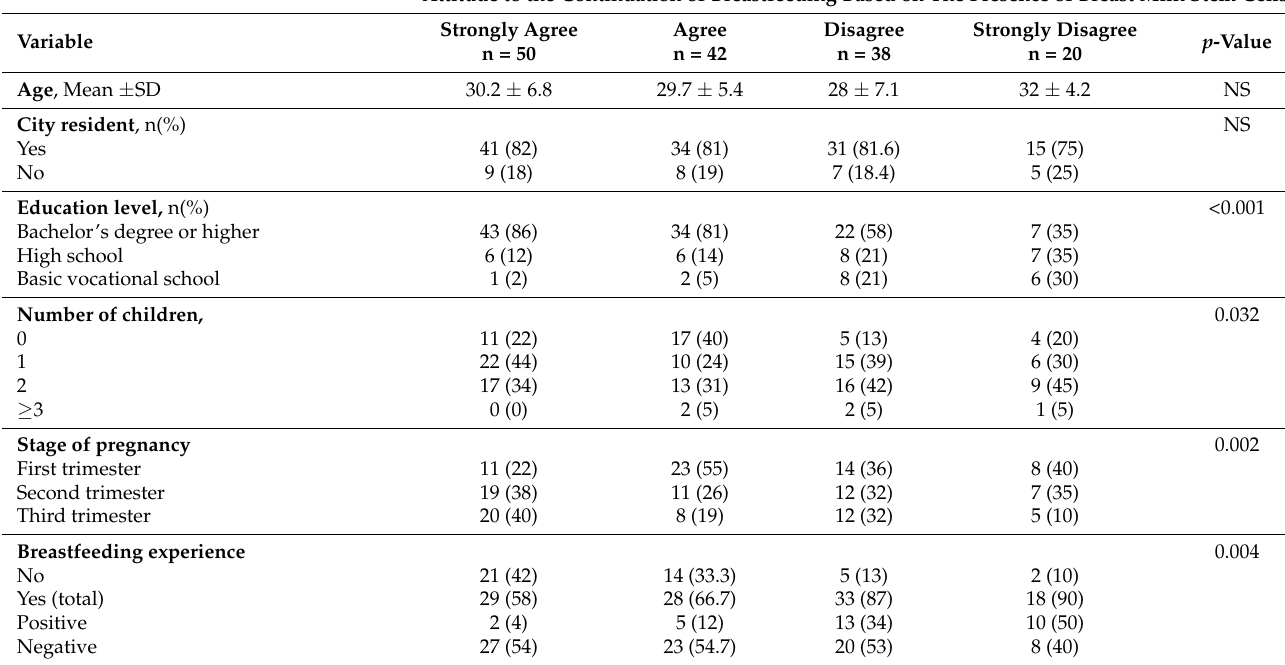
Table 5. Association between socio-demographic and obstetric characteristics of respondents and their attitude to be- gin/continue/extend breastfeeding based on awareness of stem cells in breast milk.